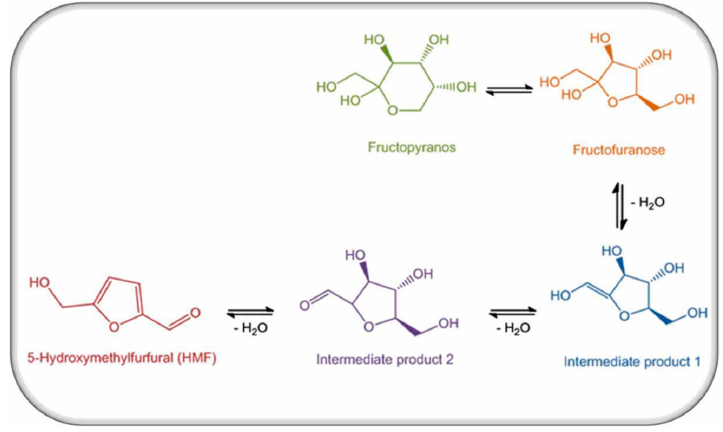
Figure 1. Production of HMF in honey.